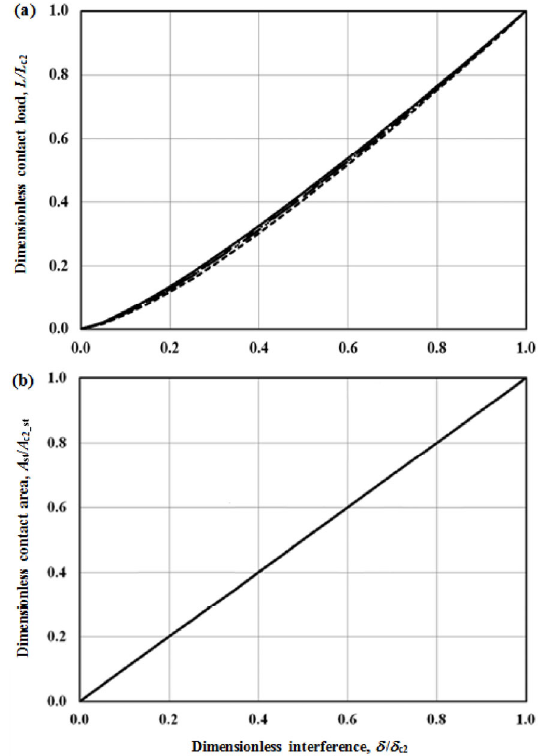
Fig. 13 (a) Dimensionless contact load L / L c2 and (b) dimensionless contact area A st / A c2_st vs. the dimensionless interference  c2 for all the cases shown in Figs. 11 and